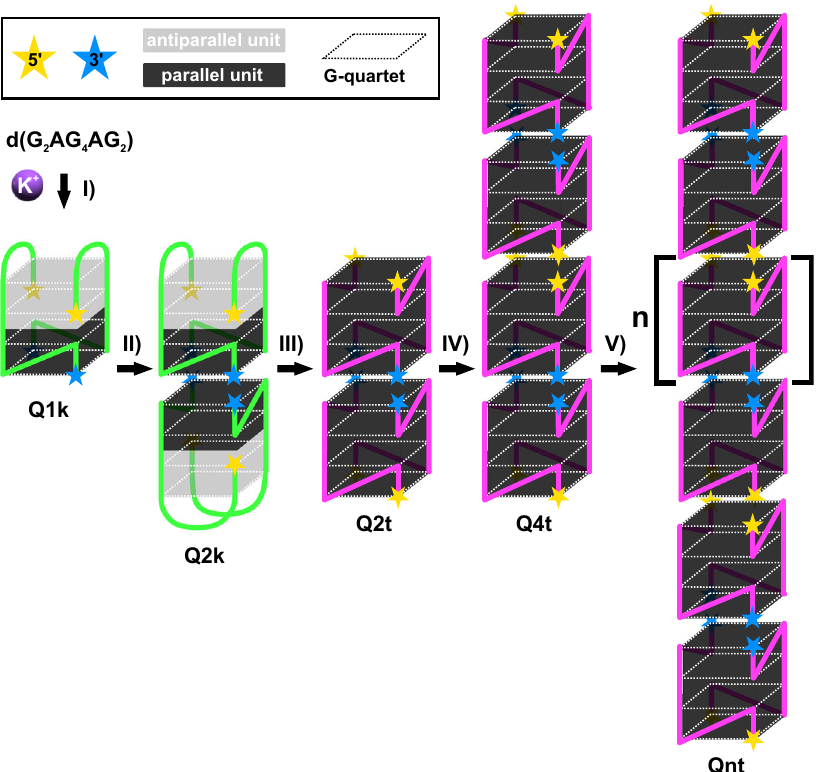
Fig. 3 A cartoon representation of d(G 2 AG 4 AG 2 ) G-wire self-assembly. The process of d(G 2 AG 4 AG 2 ) G-wire formation starts with I folding of Q1k and is followed by II 3 ′ -3 ′ stacking, which results in formation of Q2k. Both Q k-type G-quadruplexes consist of 5 ′ -antiparallel unit (gray) and 3 ′ -parallel unit (black). III Structural rearrangement of Q2k results in formation of an all-parallel Q2t. Formation of Q2t is followed by IV 5 ′ -5 ′ stacking, which leads to formation of Q4t. Subsequent V multiple 5 ′ -5 ′ stacking result in formation of Qnt G-wires with different length and n number of stacked Qt-type G- quadruplexes. Yellow and blue stars mark the 5 ′ -end and 3 ′ -end of G-quadruplexes, respectively. Dotted rectangles present (Supplementary Figs. 28 and 29). 1D 1 H NMR spectra of G-wires acquired between 5 and 25 °C exhibit a broad hump in H1 region, while broad signals on top of a hump start to appear at 35 °C, which indicates beginning of G-wires dissociation into shorter